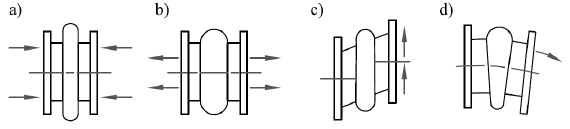
Figure 4: The displacement of the expansion joint: a) compressive; b) tensile; c) lateral; d)